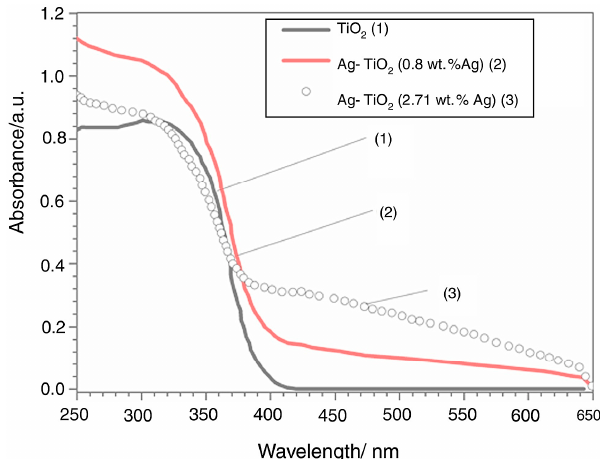
Figure 4. Ultraviolet-visible di ff use reflectance spectra of TiO 2 and its nanocomposites. Reproduced with permission from [126]. Copyright Elsevier,